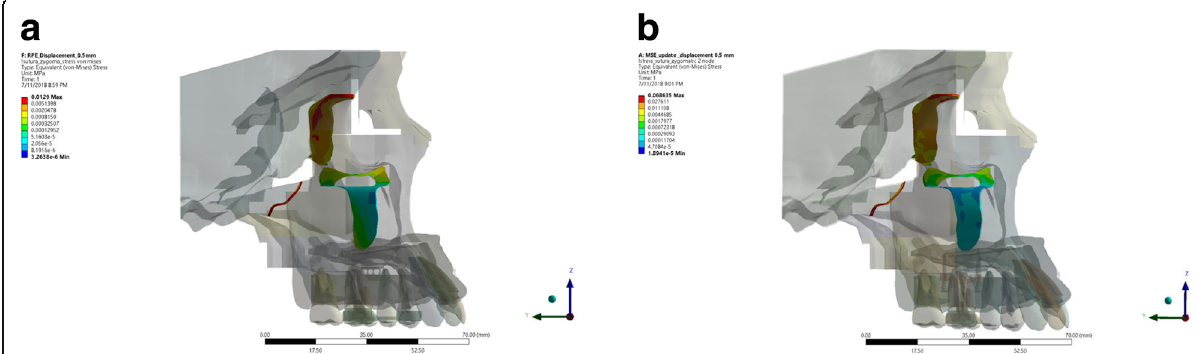
Fig. 4 The von Mises stress distribution of the zygomatic suture in the expansion simulation using ( a ) RME, and ( b ) MSE